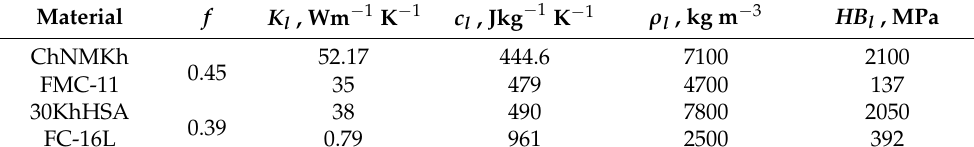
Table 1. Properties of friction pair materials at the initial temperature T 0 = 20 ◦ C [26].